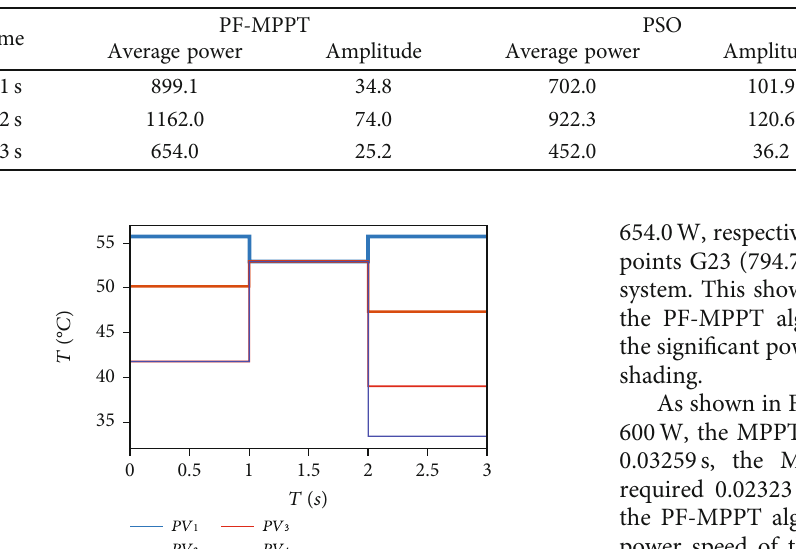
Table 5: Average power and amplitude at the operating point (unit: W).